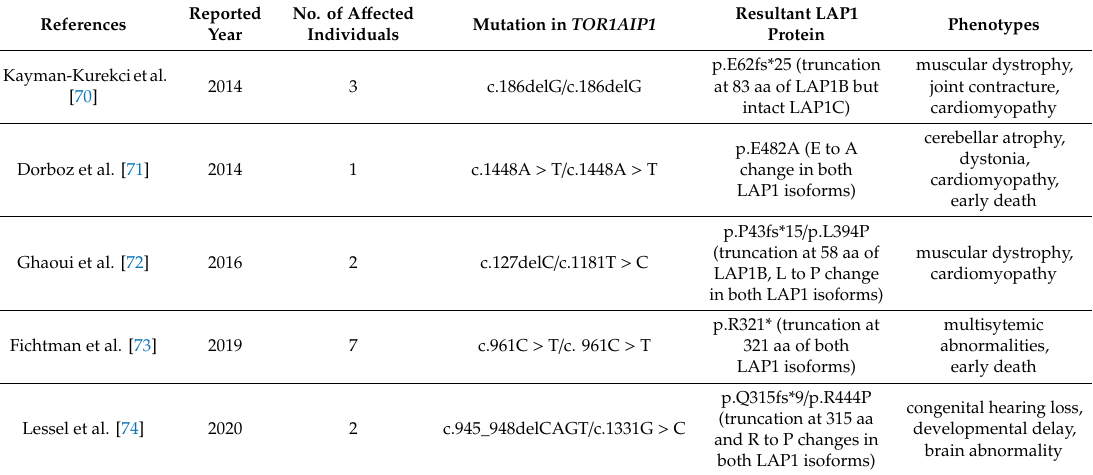
Table 1. Mutations in TOR1AIP1 associated with human